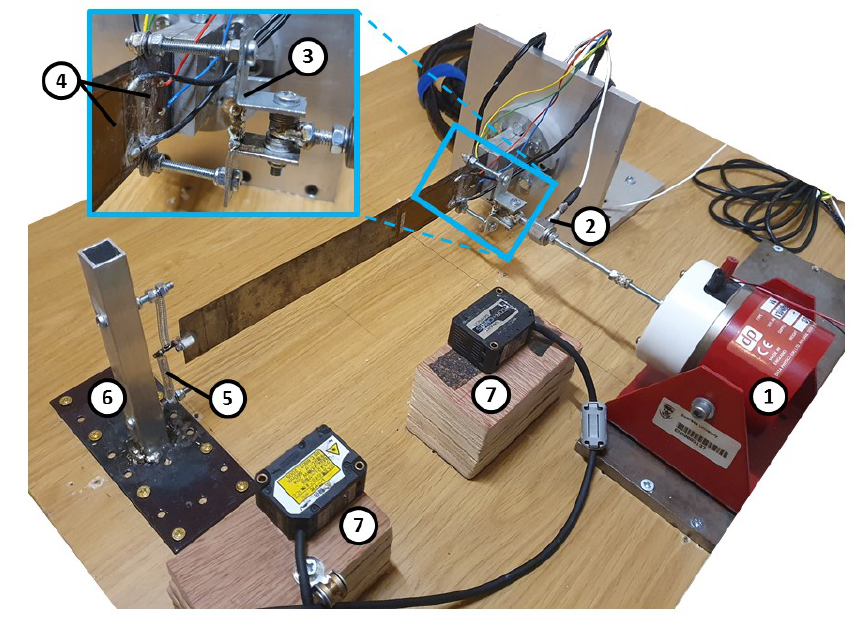
Figure 1. An image of the experimental